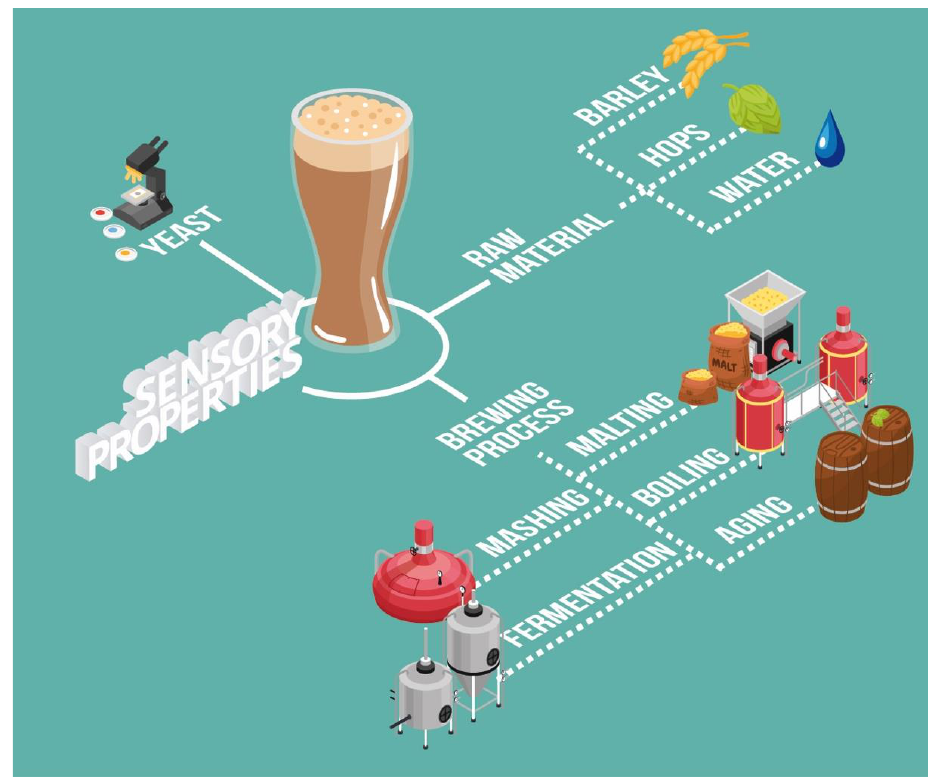
Figure 1. Main factors in the brewing process that have an influence on the sensory properties of beer.